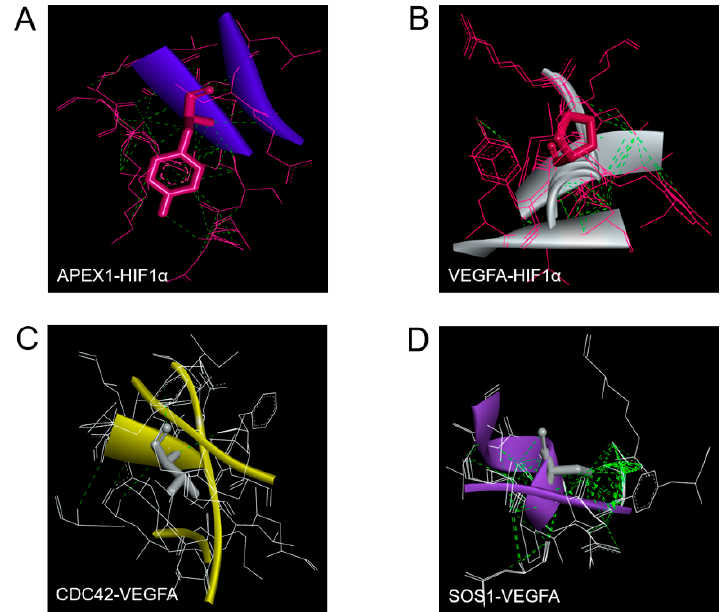
Figure 5. Representative positions of protein–protein docking. Green dash line represents the interaction bond. ( A ) Blue ribbon represents APEX1 interface to HIF-1 α (pink). ( B ) White ribbon represents VEGFA interface to HIF-1 α (pink). ( C ) Yellow ribbon represents CDC42 interface to VEGFA (white). ( D ) Violet ribbon represents SOS1 interface to VEGFA (white).